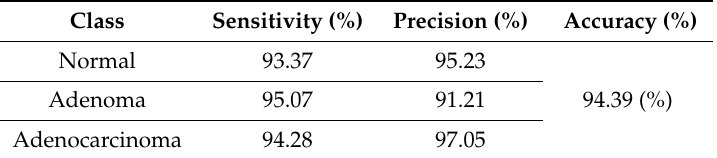
Table 8. Experimental results.